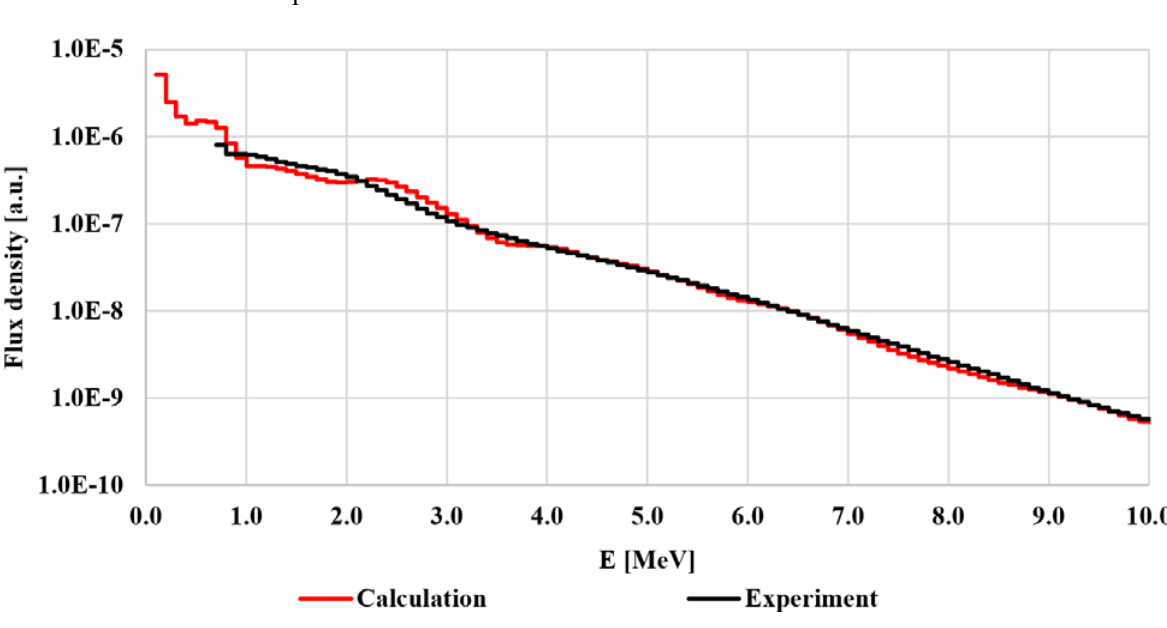
Figure 6. Neutron spectrum in